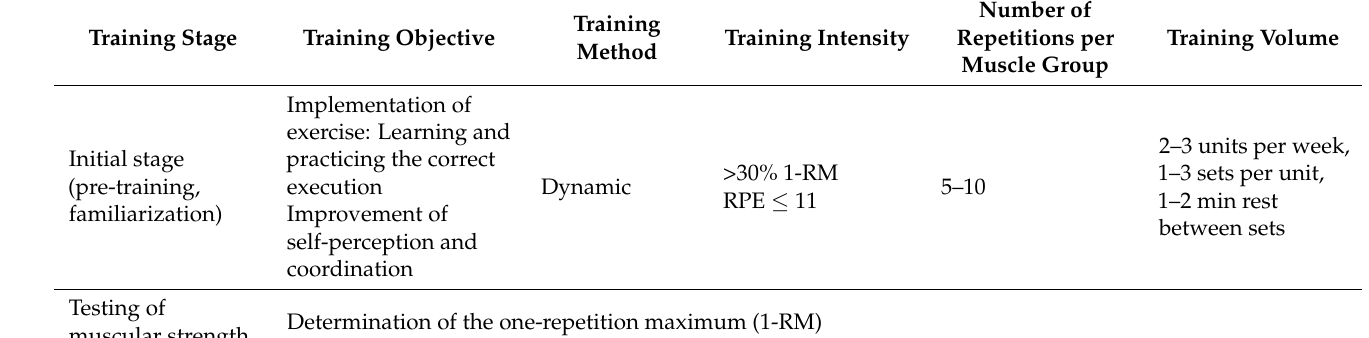
Table 4. Recommendations for setting up and performing resistance exercise within cardiac rehabilitation, modified from